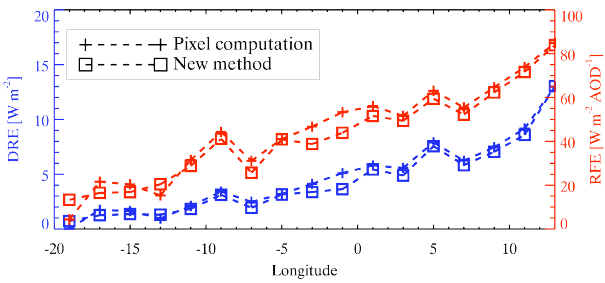
Figure 4 Meridional mean DRE and RFE for the region based on the results in Figure 3. 4 Figure 4. Meridional mean DRE and RFE for the region based on Lines with cross symbol correspond to pixel computations from(Meyer et al., 2013). 5 the results in Fig. 3. Lines with cross symbol correspond to pixel Lines with square symbol correspond to results based on the new method. 6 computations from Meyer et al. (2013). Lines with square symbol correspond to results based on the new